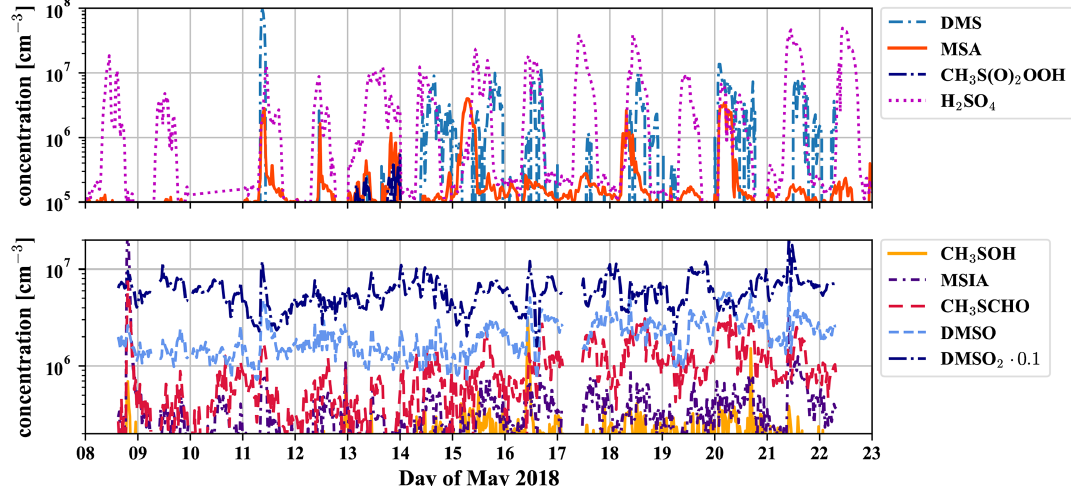
Figure D1. Time series of all detected compounds (measured by the PTR3 and nitrate-CIMS) that belong to the DMS oxidation scheme during 2 weeks of May 2018.